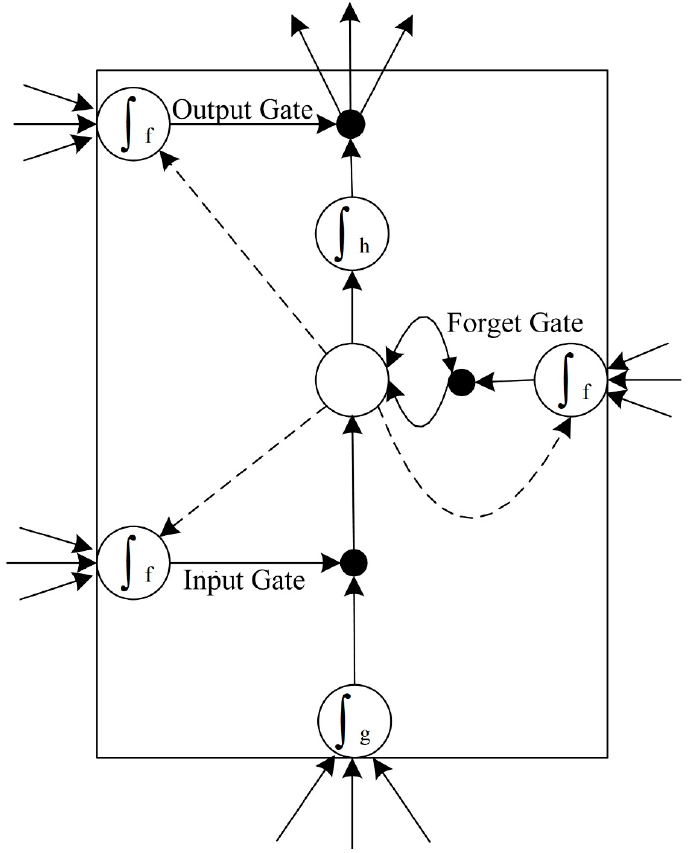
Figure 1. Schematic diagram of long short-term memory network unit module.